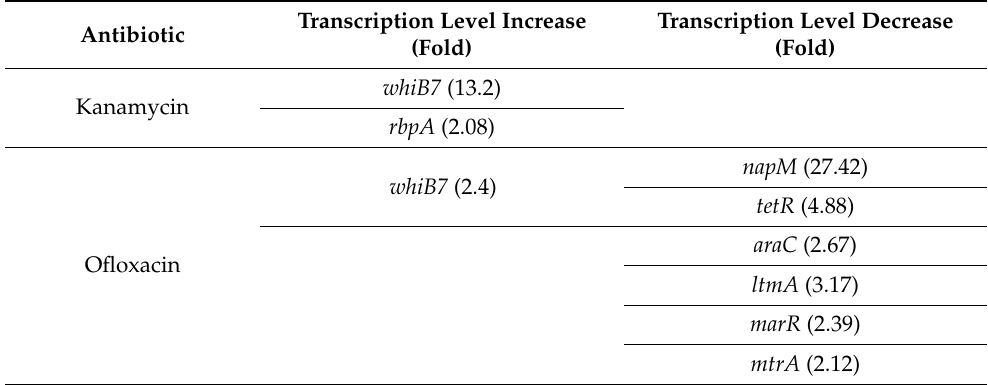
Table 4. A 2-fold or a higher change in the expression level of genes under the antibiotic stress.